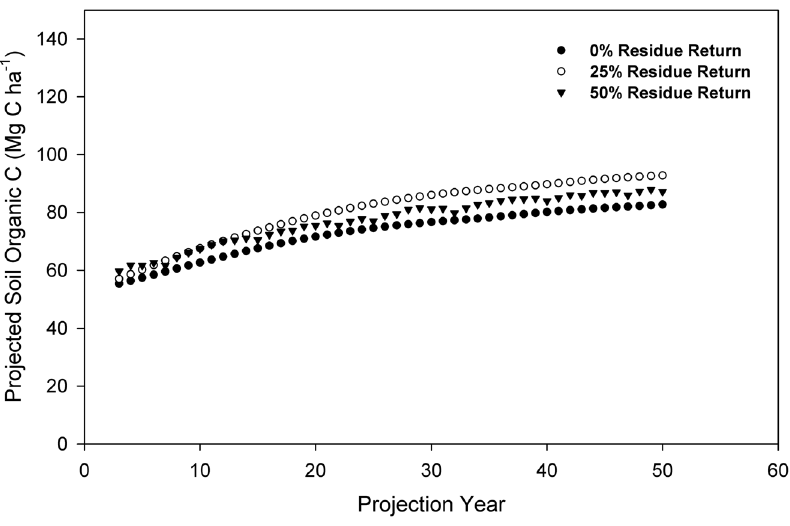
Fig. 2. Simulated soil organic C in a 50-yr period for the upper 50 cm of soil as affected by different residue removal rates under optimal N fertilization at College Station,